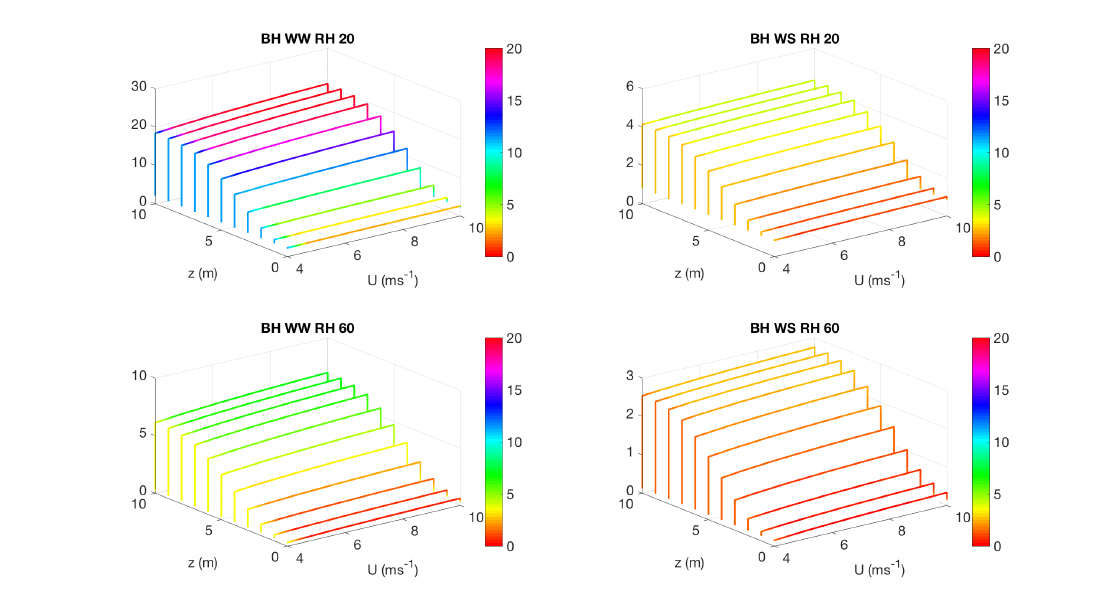
Figure 5. Variations of leaf level transpiration fe (molm − 2 leafs − 1 ) with wind speed U and height z for the bottom heavy (BH) scenario for the following four cases in low light conditions. WW RH20 means well watered, high evaporative demand; WS RH20 means water stressed, high evaporative demand; WW RH60 means well watered, low evaporative demand; WS RH60 means water stressed, low evaporative demand. Color bars show fe multiplied by 1000, x axes show wind speed U in ms − 1 and y axes show canopy height z in m.